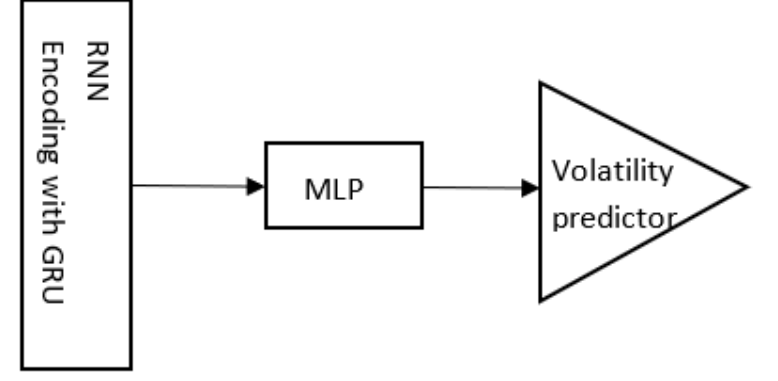
Figure 2. Architecture of recurrent neural network (RNN) model.